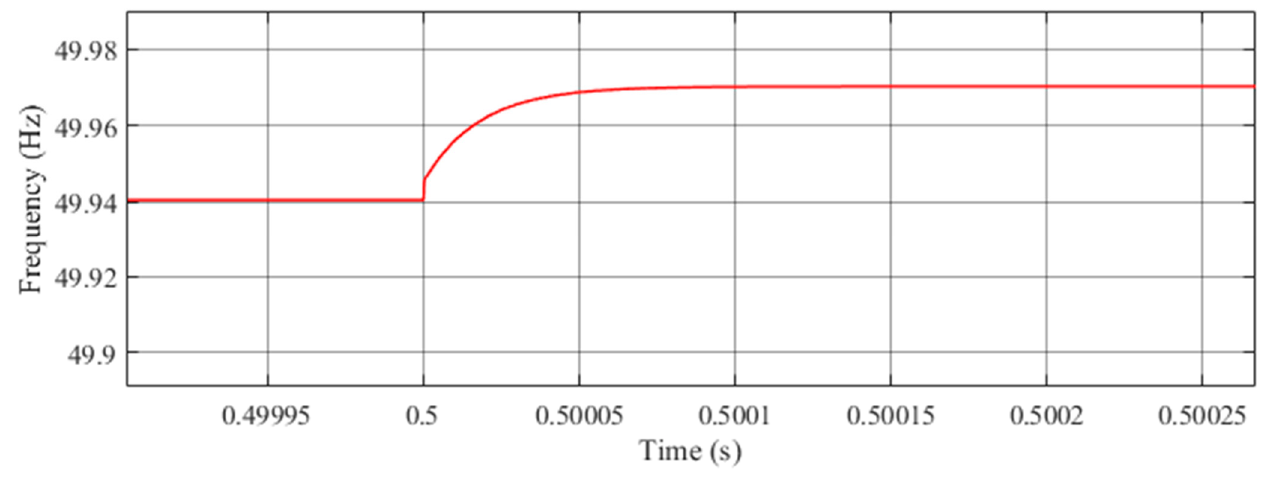
Figure 14. Frequency control with the proposed control.